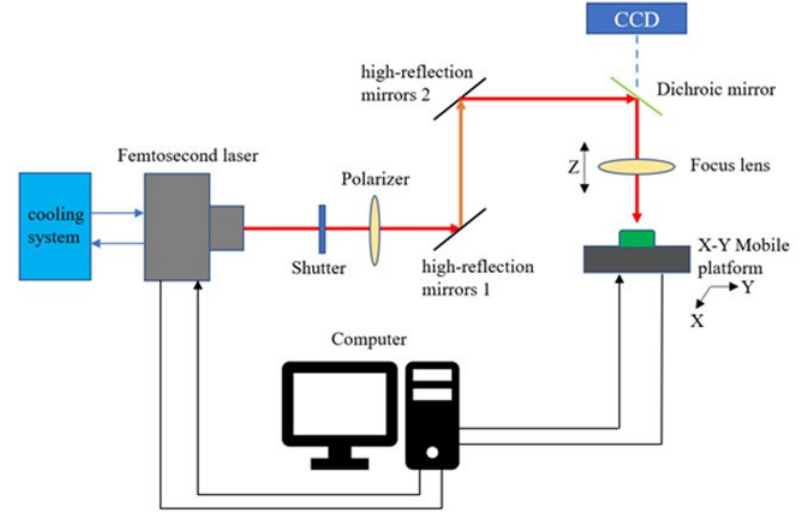
Figure 3. Schematic diagram of femtosecond laser processing